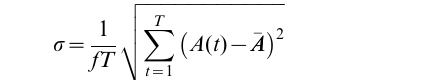
T , T stands for the stride 2